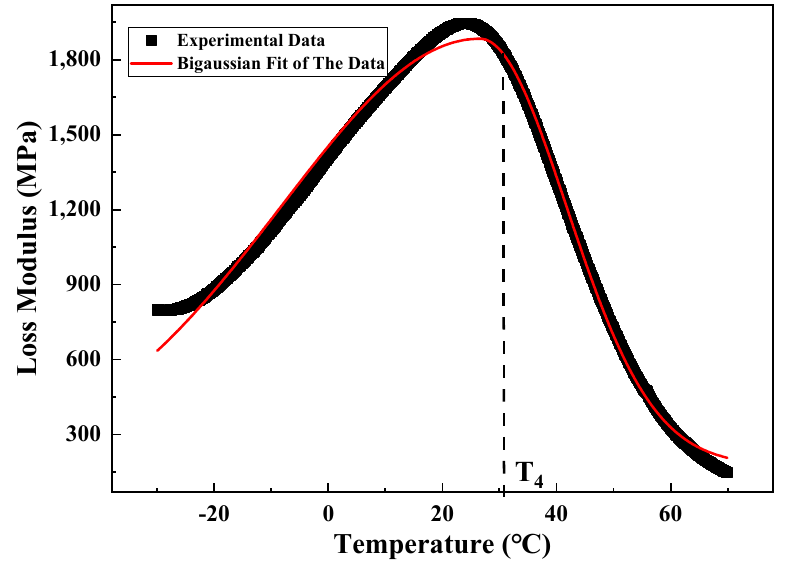
Figure 7. Schematic of the characteristic points of loss modulus.